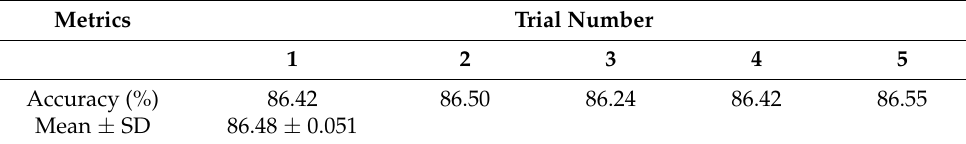
Table 6. Performance variance through repeated runs on the Twitter50 dataset.